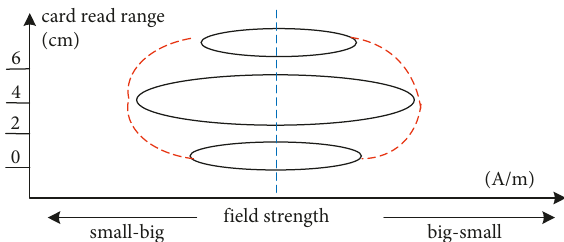
Figure 3: Equivalent circuit diagram of antenna coil. L tance; C a , parasitic capacitance; R a , parasitic resistance.